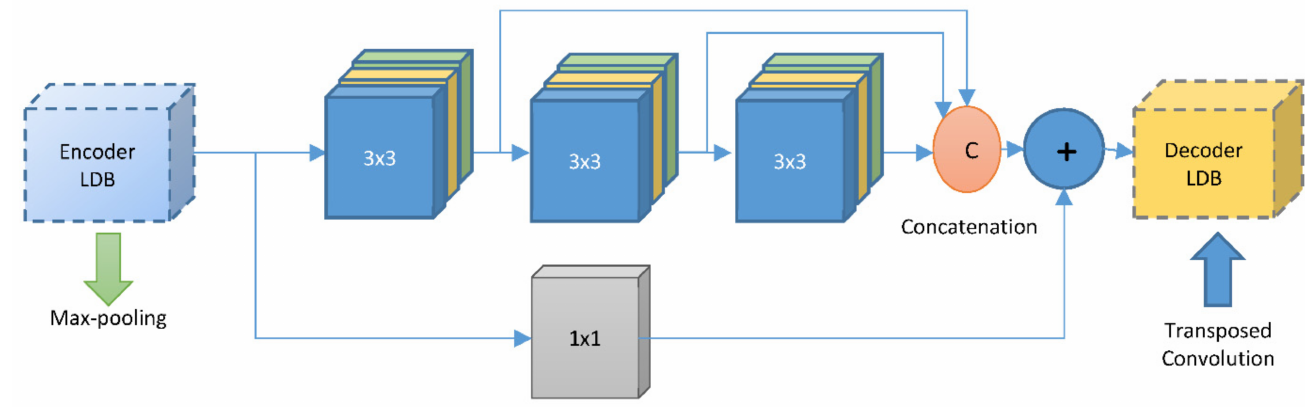
Figure 7. Multi-scale inception